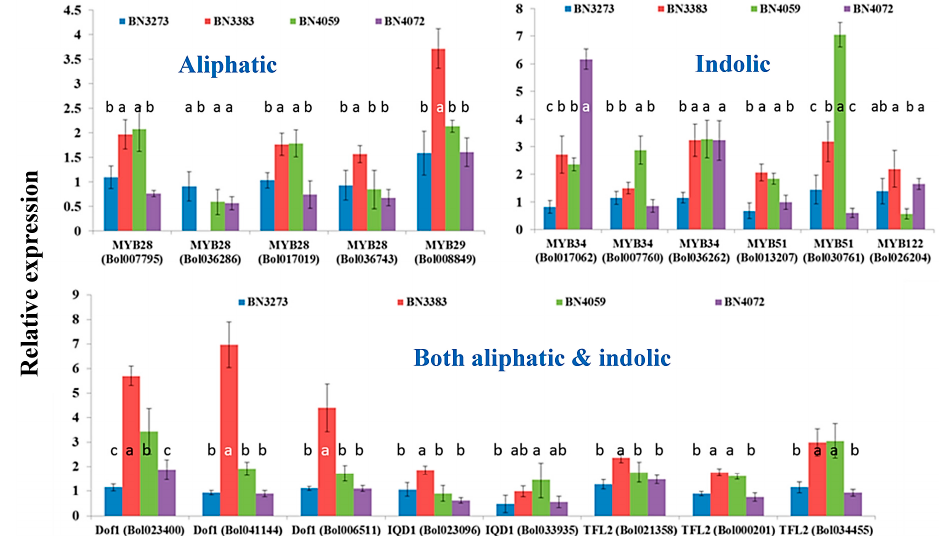
Figure 3. Relative expression level of transcription factor-related genes in four cabbage inbred lines involved in aliphatic, indolic and both aliphatic and indolic glucosinolate biosynthesis in B. oleracea . Vertical bars indicate the standard deviation of the means of nine observations. Different letters (a, b, c) indicate statistically significant difference between inbred lines.